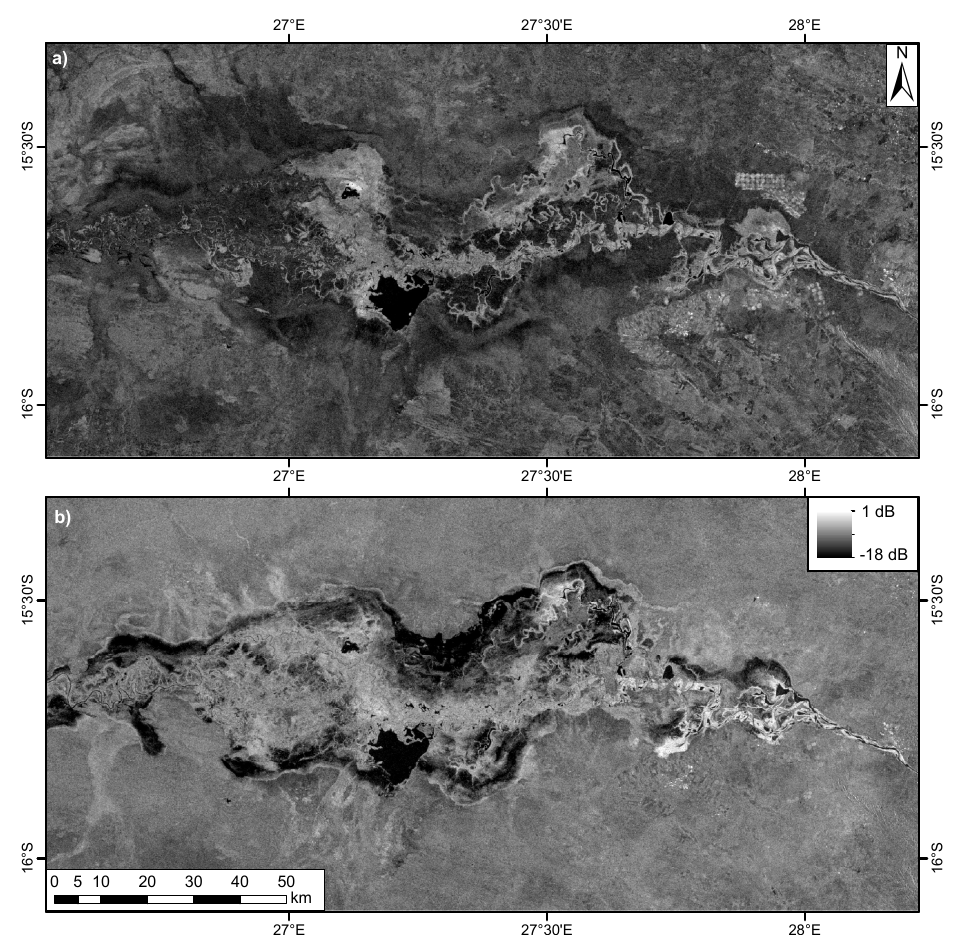
Figure 4. ENVISAT ASAR Wide Swath scenes acquired on ( a ) 10 November 2006 (dry season) and ( b ) 30 March 2007 (wet